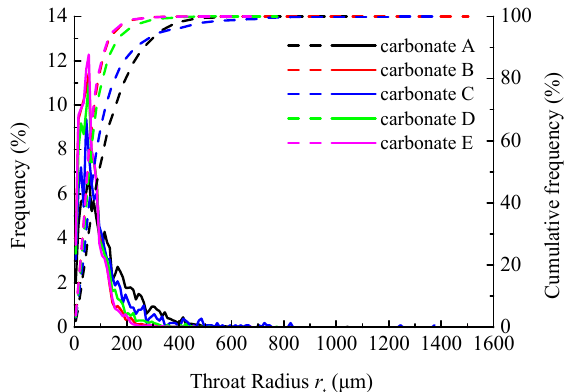
Figure 16. Distribution of throat radius in REV2s of carbonate samples.